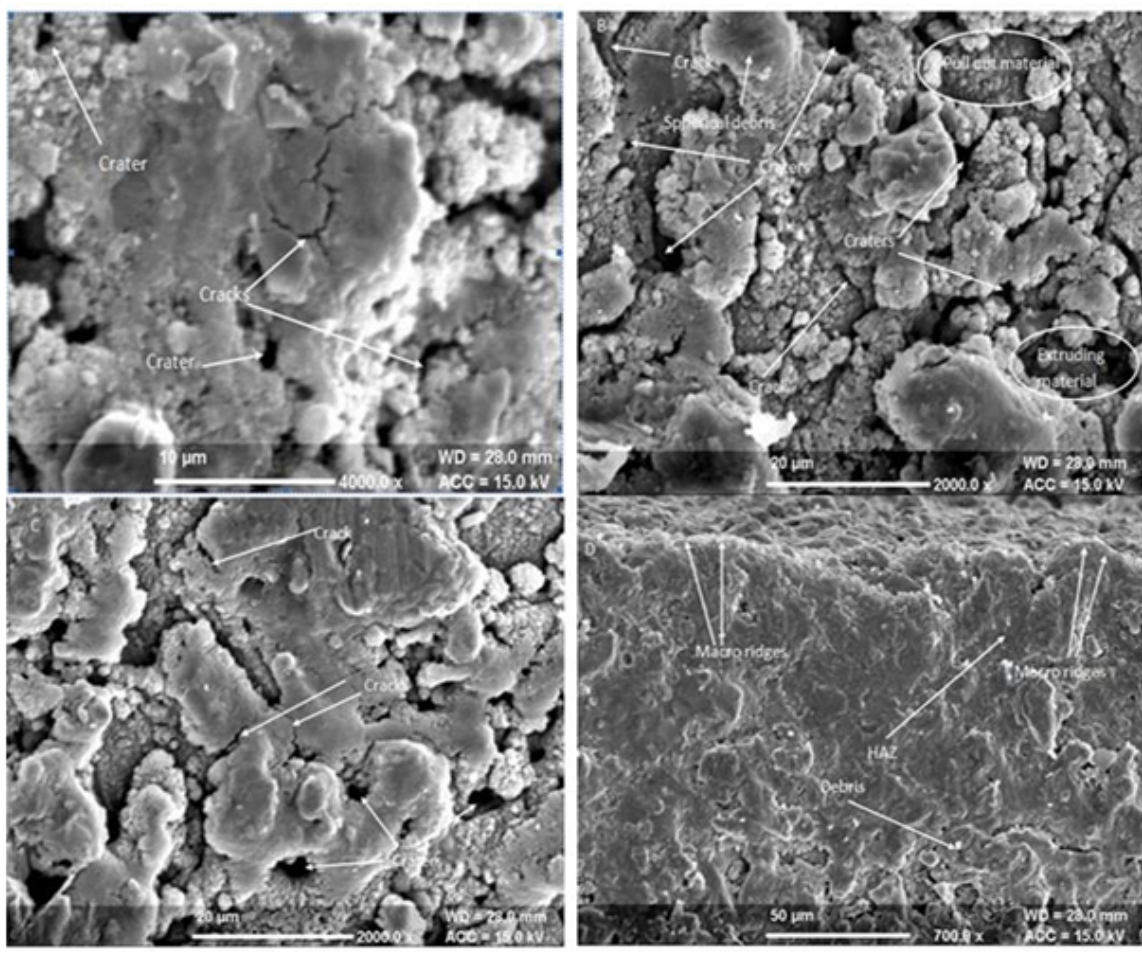
Figure 9: Scanning electron micrographs of work material for SR